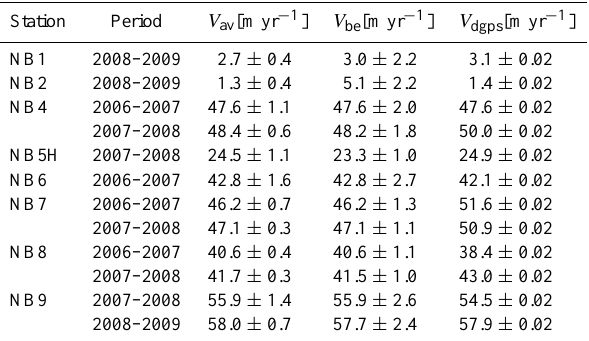
Fig. 3. Scatter plot of three years of non-averaged NBRef obser- vations (black dots) with respect to the average location, negative values denote the records to the south and/or west of the average po- sition. The grey dots indicate the location of the DGPS with respect to the averaged location, 1 = 2007, 2 = 2008. The circle denotes one standard deviation of the non-averaged NBRef data. Table 4. Comparison between GPS and DGPS determined veloc- ities of Nordenski¨oldbreen. V av is calculated using Eq. (1), with n p = n v = 240. V be is based on the distance between the 240h av- eraged beginning and end points of a GPS and V dgps is based on the yearly DGPS measurements. GPS values are calculated over the same period as spanned by the individual DGPS observations, which is about one year. Uncertainties in the GPS determined ve- locities are based on the standard deviations in the 240h average locations.